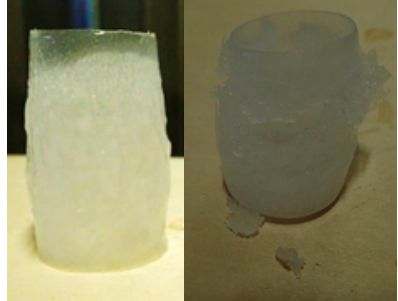
Figure 6. Removed ice sheets from graphite coating (left) and PTFE coating (right).